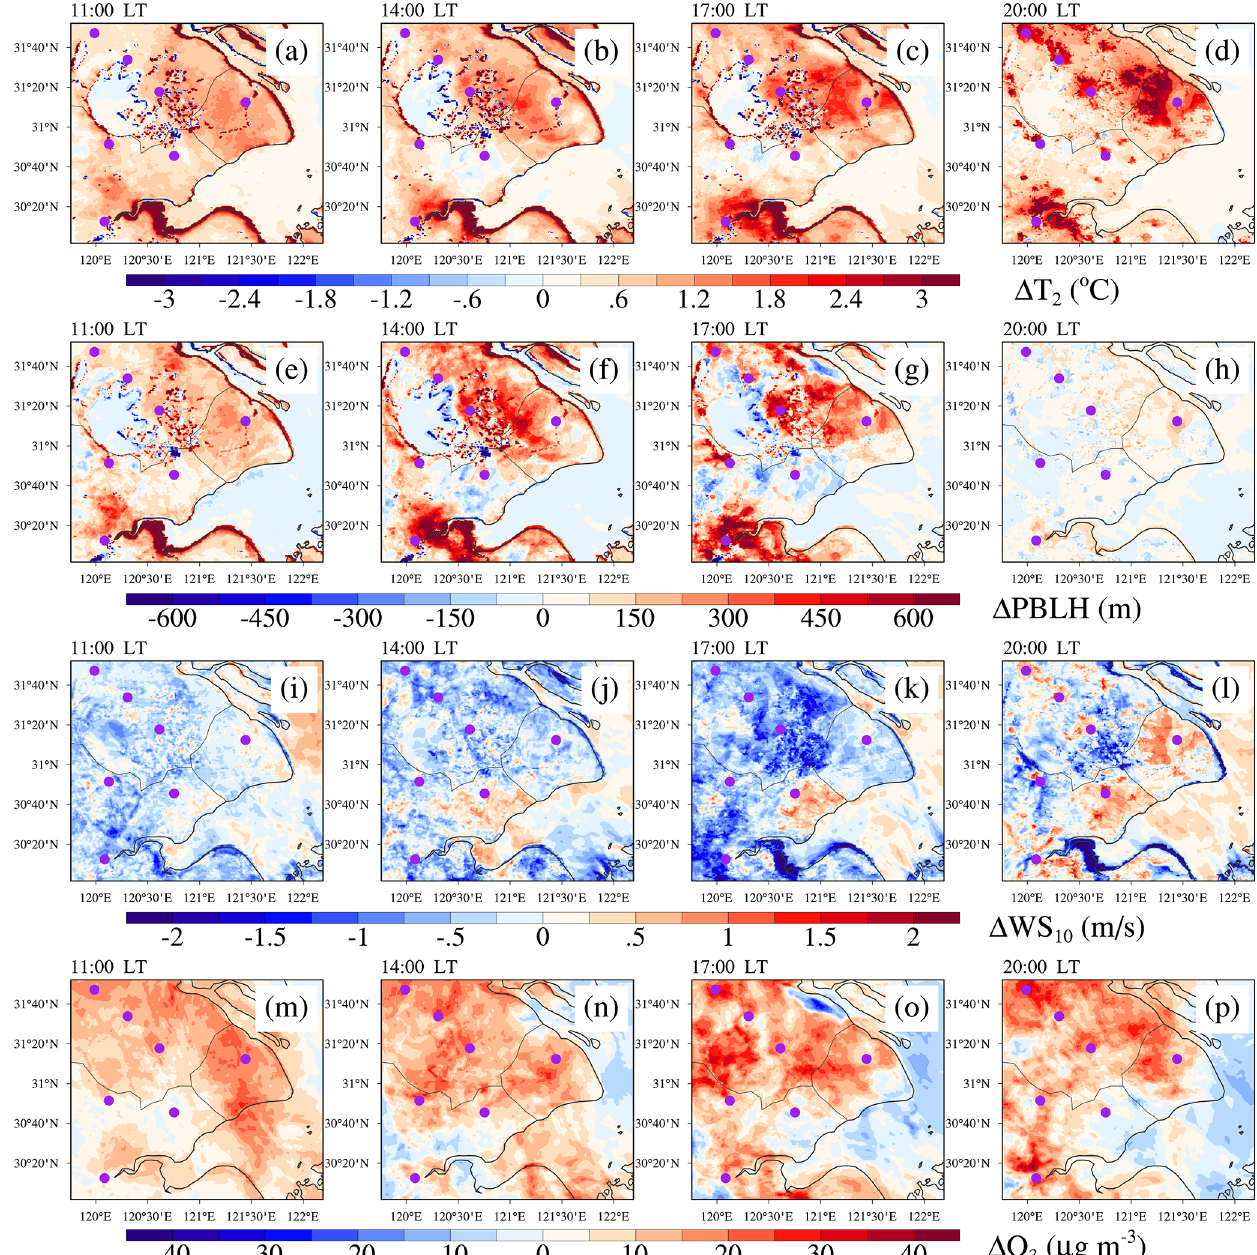
Figure 10. Horizontal distributions of the differences in (a–d) T 2 , (e–h) PBLH, (i–l) WS 10 and (m–p) O 3 between MODIS_noAH and USGS_noAH (MODIS_noAH − USGS_noAH) during the daytime. The purple dots represent the locations of cities in the innermost